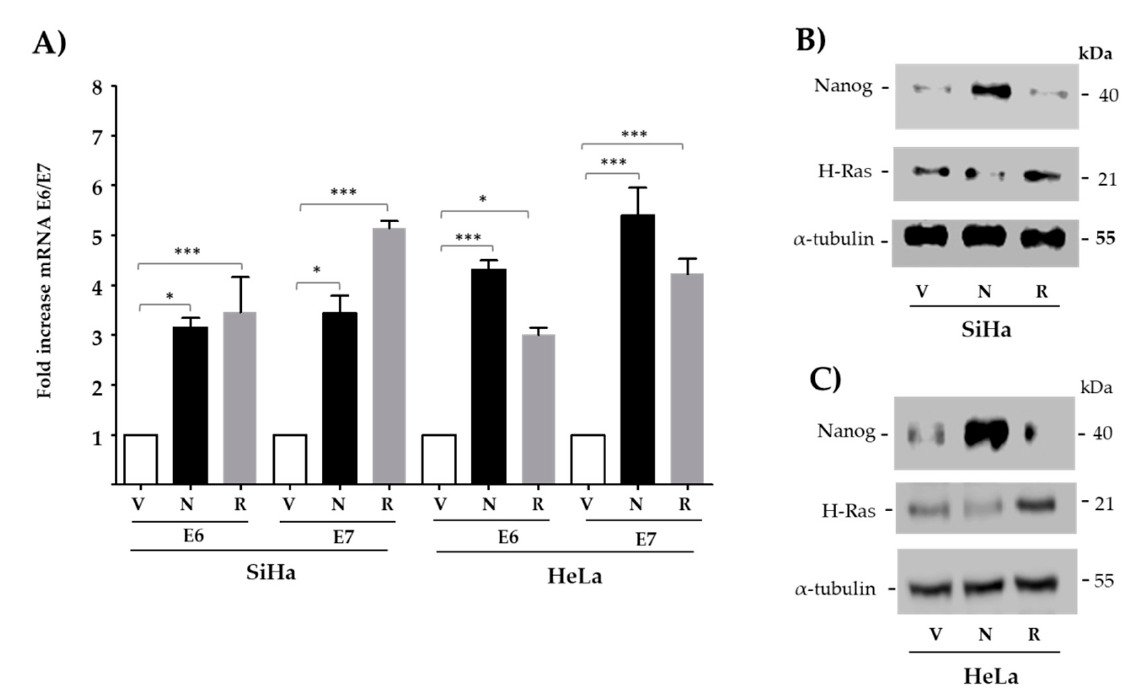
Figure 2. Nanog increases E6 and E7 expression. ( A ) SiHa and HeLa cells were transiently transfected with empty vector (V), Nanog (N), and H-Ras V12 (R), as a positive control. ( A ) RT-qPCR of E6 and E7 was performed. The means and ± SD of three independent experiments (in triplicate) are depicted in the graph. One-way ANOVA test with a Tukey analysis was performed to evaluate the significant differences. * p < 0.05, *** p ≤ 0.001. ( B , C ) SiHa and HeLa cells were reverse transfected and Nanog or H-RasV12 protein expression evaluated using α -tubulin as protein loading control.